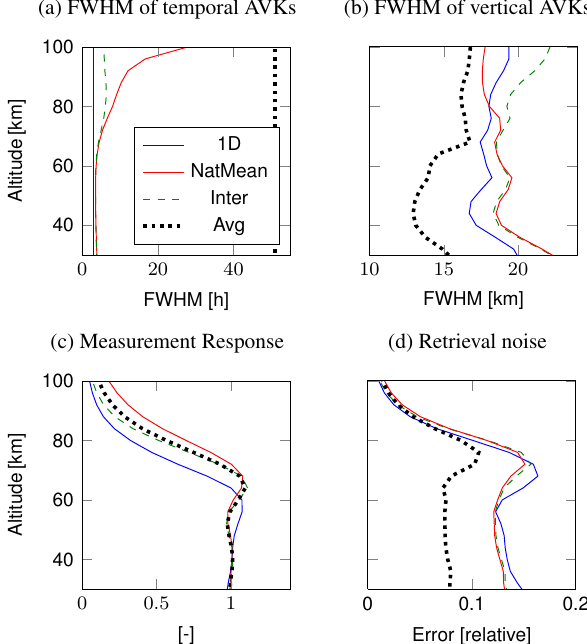
Fig. 5: Properties of the simulated retrievals at the the 120 th hour. Plot (a) is the FWHM of the temporal AVKs, plot (b) is the FWHM of the vertical AVKs, plot (c) is the measurement response from the retrievals, and plot (d) is the retrieval noise from the retrievals in units relative to the a priori concentration. The different curves represent the single spectrum inversions (blue), the time series inversions using the NatMean (red) and the intermediate covariance matrix (dashed-green), and the inversions using the averaged spectra (black-dashed).